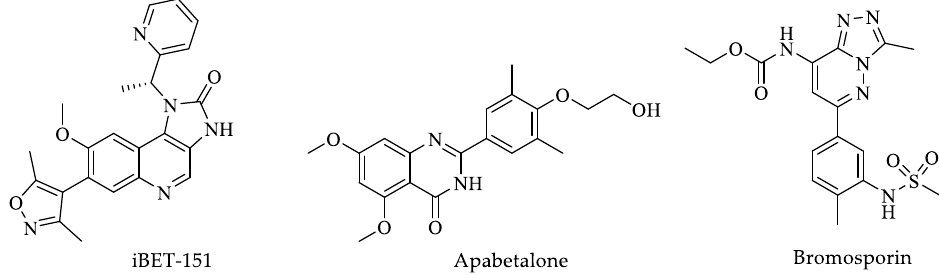
Figure 3. Structure of compounds with Tc BDF2 inhibitory activity of T. cruzi .